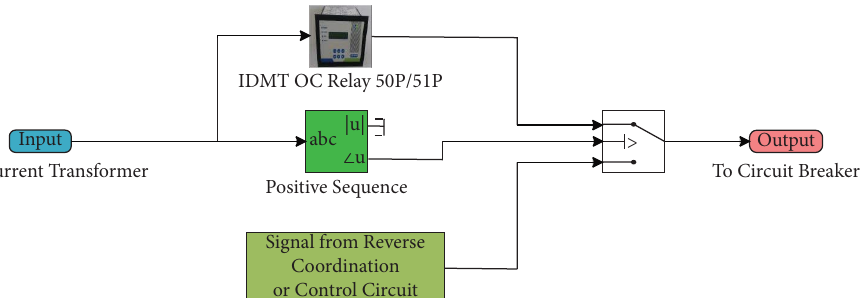
Figure 15: Proposed protection scheme on MATLAB/Simulink.